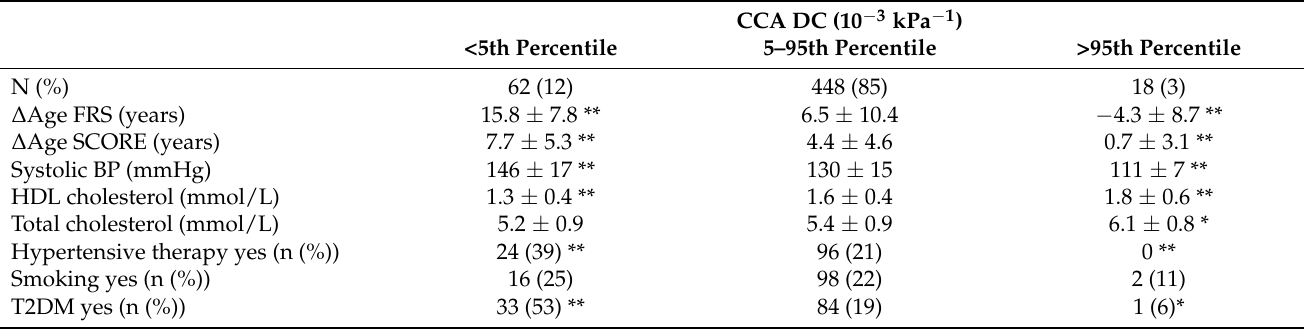
Table 3. Arithmetic difference between risk-based vascular age and chronological age ( ∆ Age) and es- tablished risk factors according to percentiles of carotid distension coefficient in reference